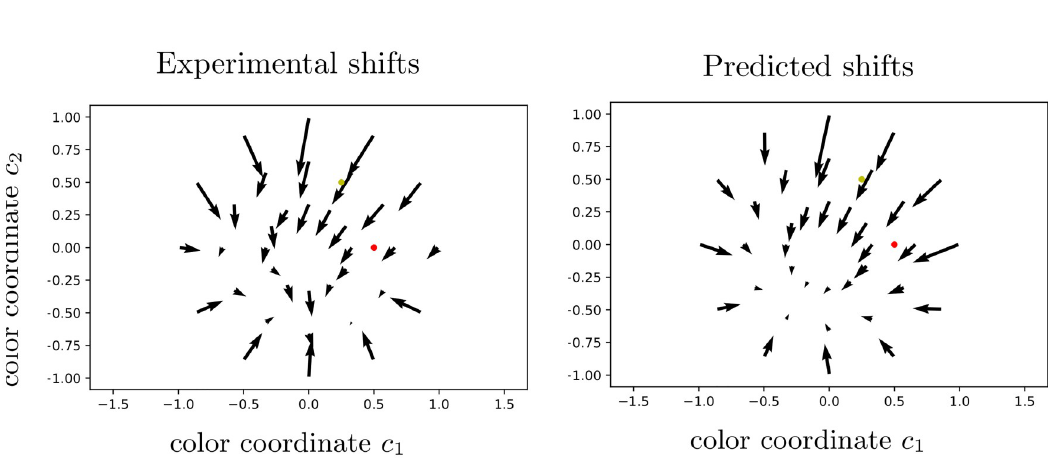
Fig 14. The color neural field model reproduces nonlinear shifts in the chromatic disk. Left. 36 pairs of experimental data points (test and matching colors) in the HSL chromatic disk at constant luminance, resulting from averaging the shifts (refer to Data section and Fig 5). Right. Predicted